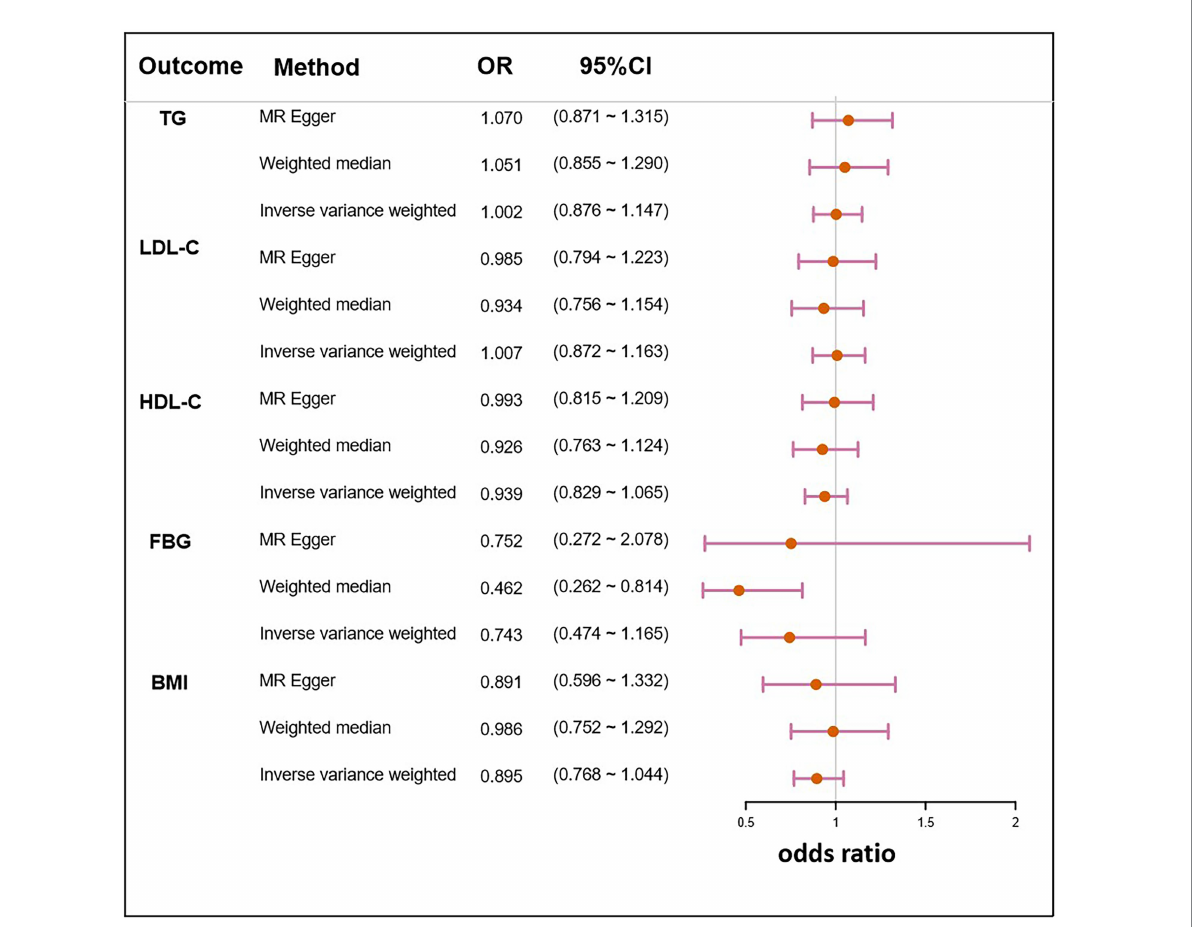
FIGURE 5 Mendelian randomization result of the effect of clinical traits related to NAFLD on H. pylori infection. LDL-C, low density lipoprotein cholesterol; HDL-C, high density lipoprotein cholesterol; FBG, fasting blood glucose; BMI, body mass index; OR, the odds ratio. 95% CI, 95% confidence